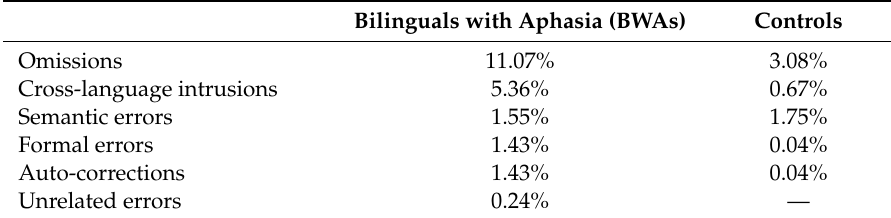
Table 4. Error distribution for BWA and control groups in single-language blocks. Error types expressed as percentage of overall number of single-language